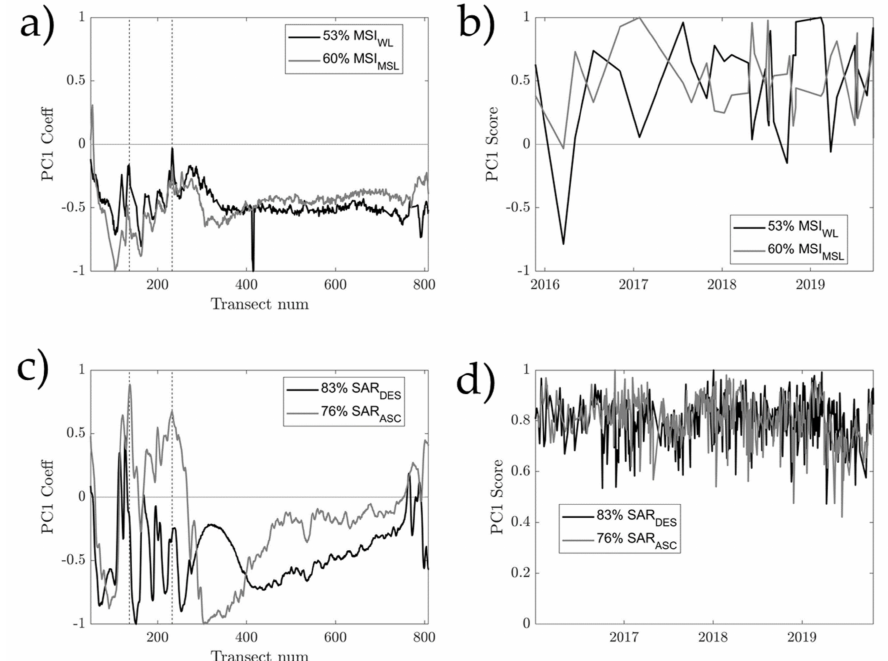
Figure 18. First Principal component (PC1) spatial and temporal results of the Start Bay area using MSI WL & MSL, and SAR DES & ASC. The percentage of total variability explained is indicated in each figure legend. The alongshore distribution of the PC1 coefficients ( a , c ) shows dominant patterns in shoreline change, and the time series of the PC1 scores ( b , d ) illustrates any temporal association of these key modes. The values shown for both coeff. and scores has been normalized by the maximum absolute value to represent results from different datasets in the same